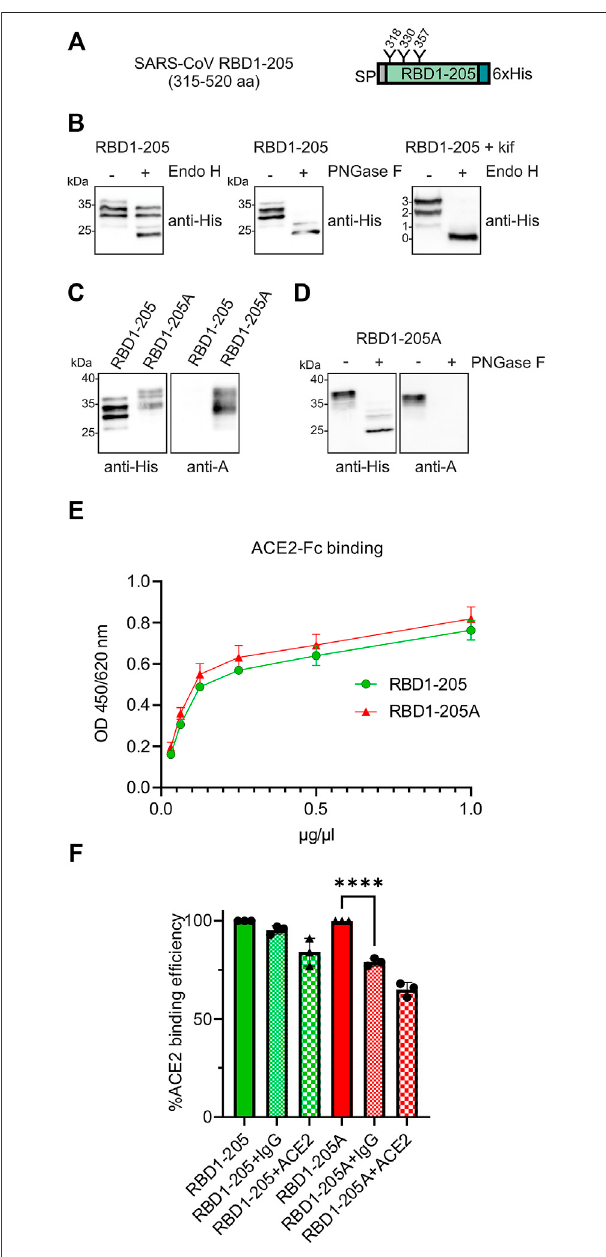
FIGURE 7 | RBD1-205 N-glycans can be engineered to carry blood group A antigens. (A) Illustration of the plant-expressed RBD1-205 (amino